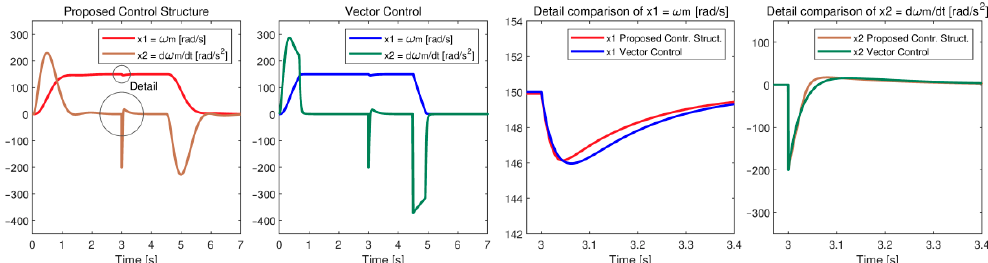
Figure 11. Comparison of dynamic properties of the controlled drive with the induction motor: the proposed and the vector control structures.